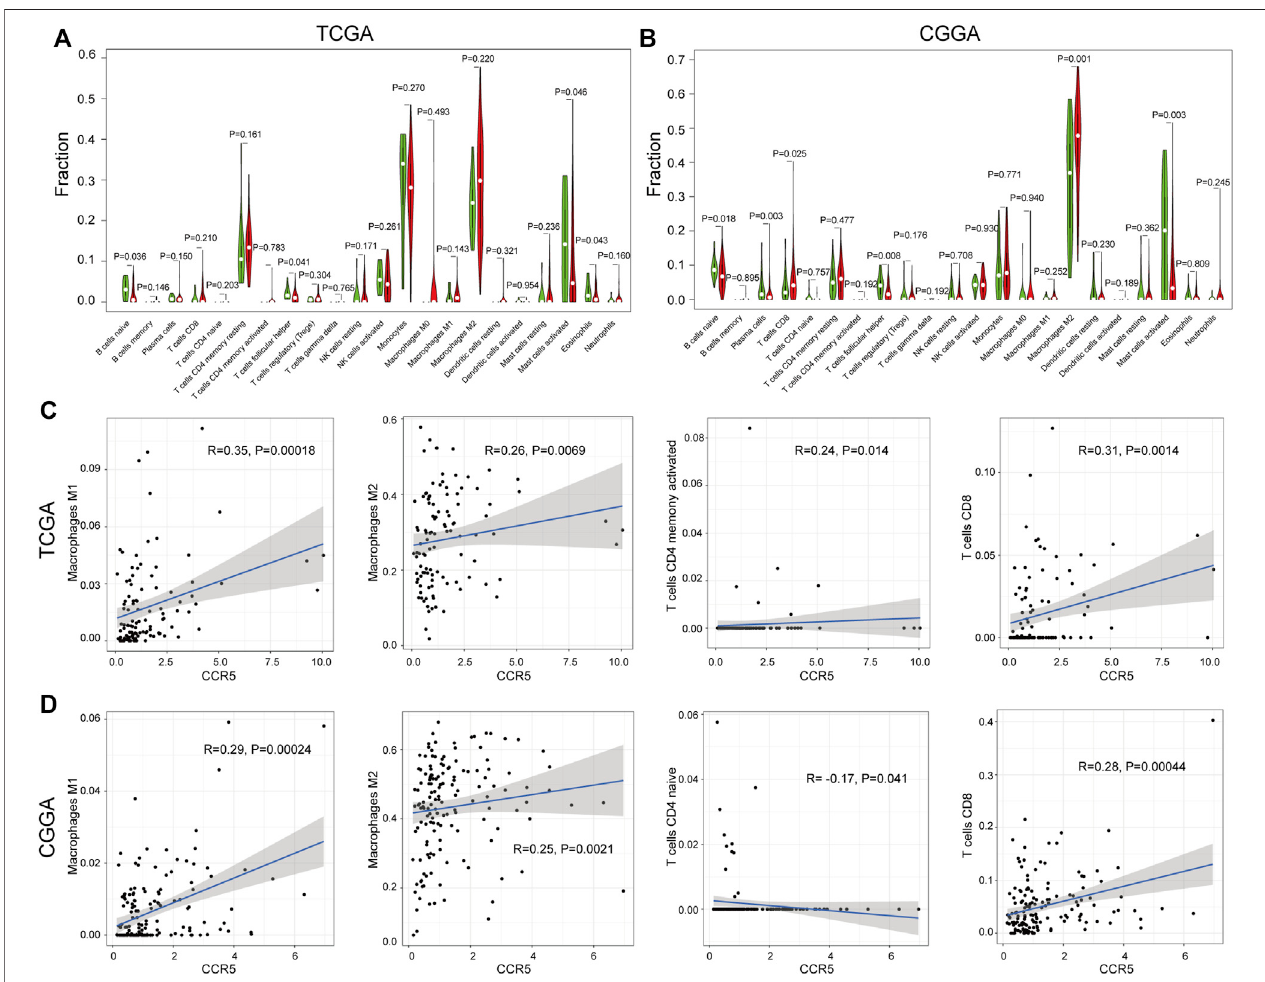
FIGURE 7 | Correlation analysis between CCR5 and TICs. The difference analysis of TICs based on the expression of CCR5 in the TCGA and CGGA database, respectively (A,B) . The correlation analysis of CCR5 with macrophages, CD4 + memory-activated, and CD8 + T cells based on the TCGA database (C) . The correlation analysis of CCR5 with macrophages, CD4 + naive, and CD8 + T cells based on the CGGA database (D)